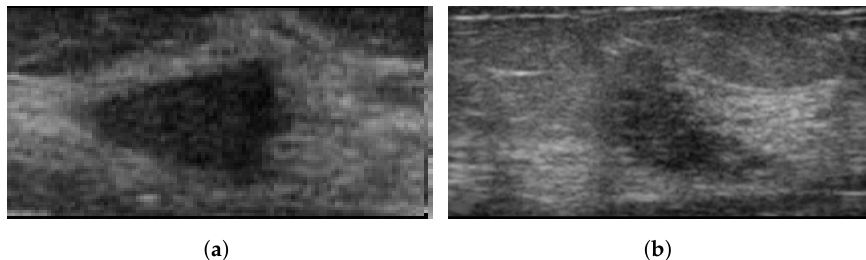
Figure 5. Sample images from the BUS database. ( a ): benign; ( b ): malignant.